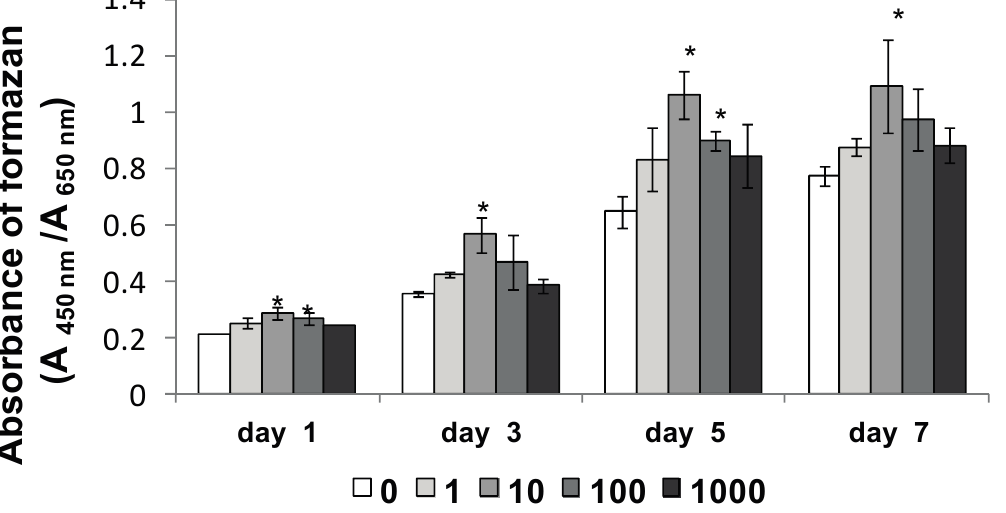
Figure 1. Effect of synthetic peptide (SP) on cell proliferation. mesenchymal stem cells (MSCs) were seeded in 96-well plates at 2 × 10 3 cells/well in normal culture medium. After a 24-h culture for cell adherence, the medium was replaced with normal culture medium containing SP (0, 1, 10, 100 or 1000 ng/mL) and MSCs were incubated for 1, 3, 5 and 7 days. Cell proliferation was measured on days 1, 3, 5 and 7. * p < 0.05 vs. SP (0 ng/mL), at days 1, 3, 5 and